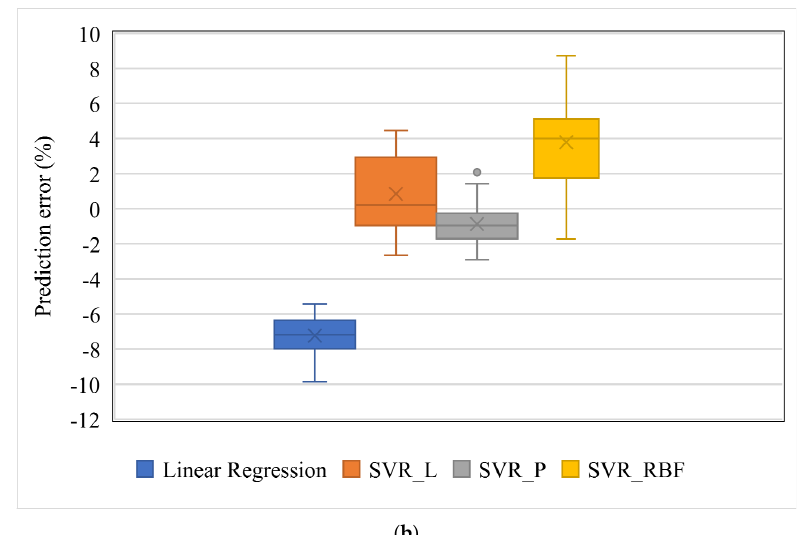
Figure 4. Comparison of linear regression (LR) models and SVR models with linear (SVR_L), polynomial (SVR_P), and radial basic function (SVR_RBF) kernels: ( a ) scatter plot, and ( b ) box plot with median line and mean X. The influence of the feature selection on the prediction accuracy using SVR_P is depicted in Figure 5. Two subgroups, stretch features (Area_L, ArcLength_C, and ArcLength_F) and calcification features (Area_C, Angle_C, and Thickness_C), were compared with the group with all eight features. For the subgroup with calcification features, the prediction error ranged from 3.20 to 9.42%, with the bias as 6.05%. For the subgroup with stretch features, the error ranged from − 1.56 to 6.18%, with the bias as 1.56%. For the group with all eight features, the error ranged from − 2.89% to 2.08%, with the bias as − 0.87%. The group with all eight features demonstrated a better prediction capability than both subgroups. It is interesting to see that the stretch features performed better than the calcification features. The difference among the biases of these three groups is statistically significant (F = 148.9, p <0.01). Further, a simple t-test also demonstrated a statistically significant difference between stretch features and calcification features (t = 66.97, p < 0.01).